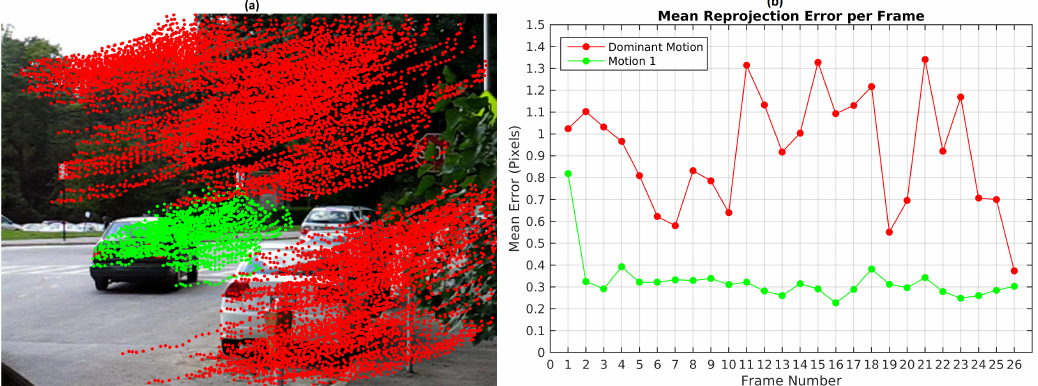
Figure 8. TbD-SfM results for Scene 3: ( a ) Motions segmented; ( b ) Mean reprojection error